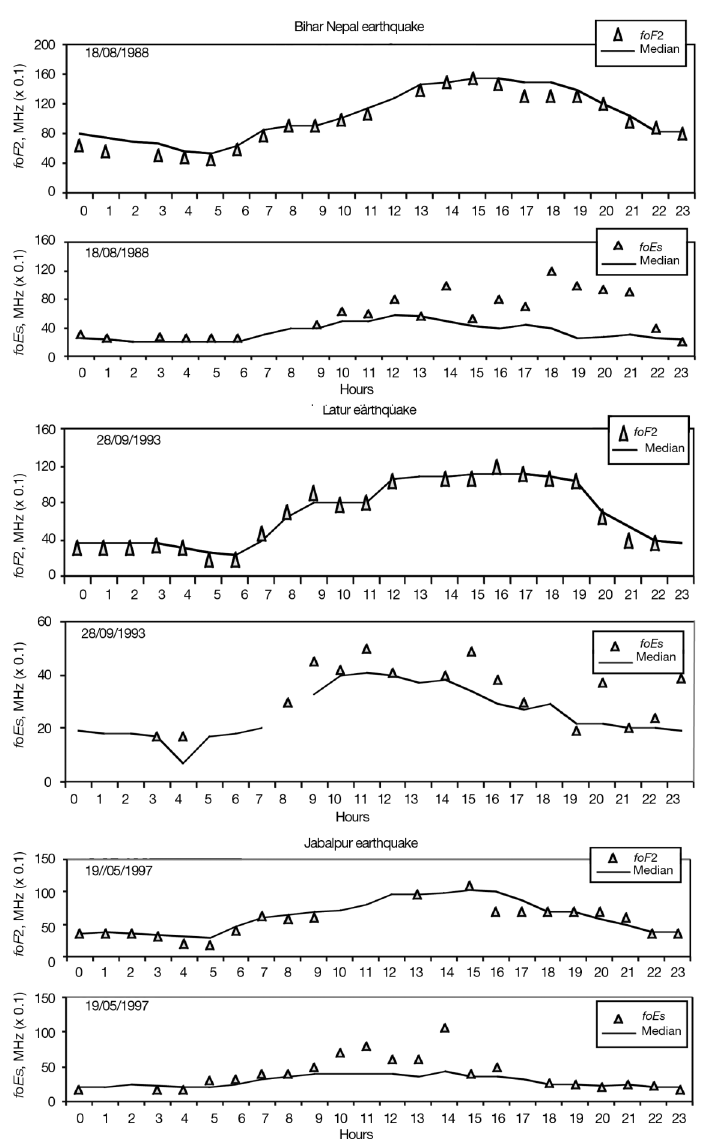
Fig. 2b. Temporal variation of monthly median foF 2 and foEs (solid curves) and hourly measured values (open triangles) on the days of observed anomalies corresponding to the earthquakes under